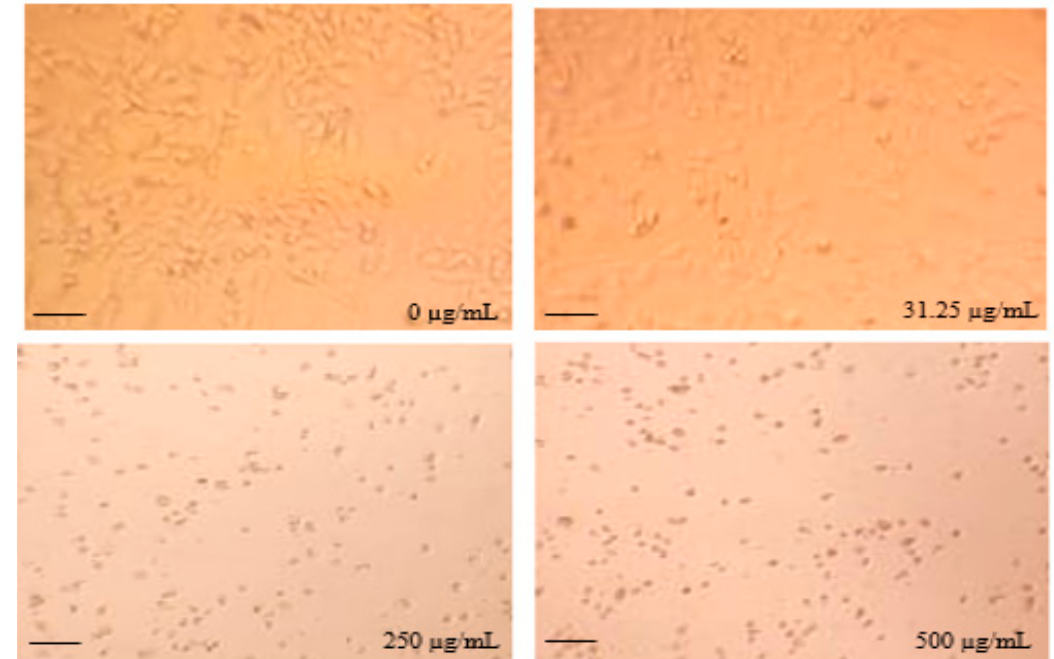
Figure 2. Photograph of MDA-MB231 cancer cell lines after 72 h of post-treatment with C. colocynthis seed extract (Scale bare = 0.5 cm).